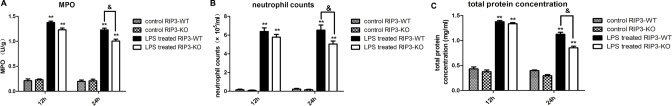
RIP3 depletion reduced the tissue MPO activity, neutrophil influx and total protein concentration in BALF in LPS-induced ARDS.(A) The MPO activity in lung tissue. (B) The neutrophil counts in BALF. (C) The total protein concentration in BALF. RIP3-WT and RIP3-KO mice were divided into two groups. The LPS group mice were instilled with 30 mg/kg LPS, while the control group mice were instilled with PBS. The mice were sacrificed 12 h or 24 h after LPS instillation. The data were presented as mean±s.e.m. (n = 10). **P<0.01 versus the respective control group; &P<0.05 versus the LPS treated RIP3-WT group.